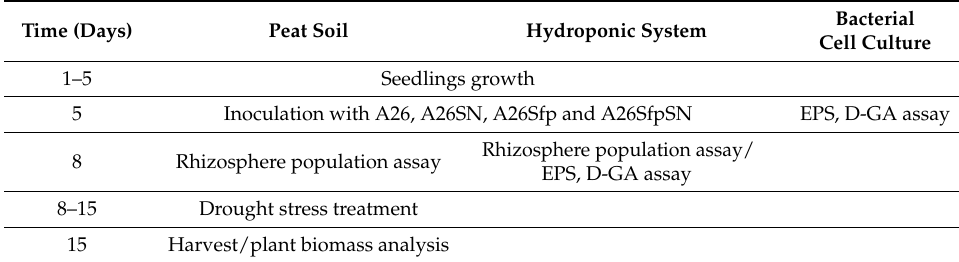
Table 1. Summary of experimental